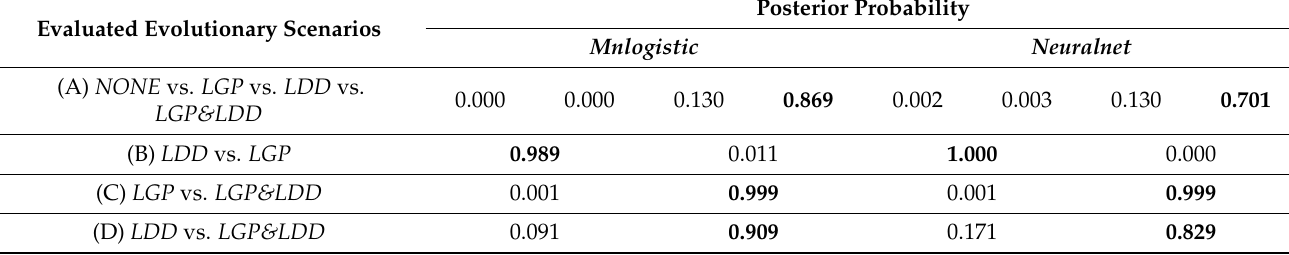
Table 1. Fitting of the studied evolutionary scenarios with the observed genetic data. The table shows the fitting (posterior probability estimated with the mnlogistic and neuralnet methods) of each evolutionary scenario with the observed data in diverse evaluations: (A) all the studied evolutionary scenarios together; (B) the evolutionary scenarios LDD and LGP ; (C) the evolutionary scenarios LGP and LGP & LDD ; (D) the evolutionary scenarios LDD and LGP & LDD . Additional evaluations with the evolutionary scenario NONE are not included because this scenario always produced the worst fitting. The best-fitting evolutionary scenario (and its posterior probability) for each evaluation is presented in